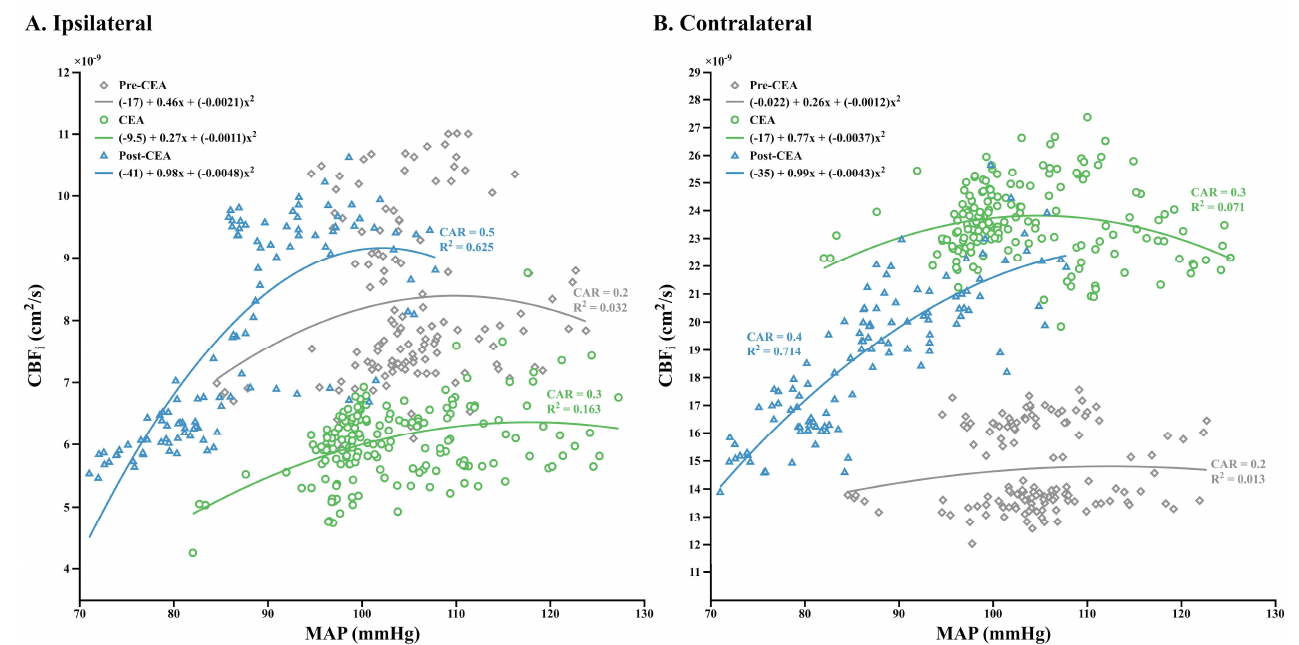
Figure 5. A representative case of ipsilateral ( A ) and contralateral ( B ) CBF i versus MAP in a patient (#21, MCS group). In the ipsilateral hemisphere, there was a decrease of CBF i for MAP below 85 mmHg during the post-CEA phase, suggesting the loss of cerebral autoregulation for these MAP values. In contrast, during the pre-CEA and CEA phases, CBF i did not increase despite MAP being above 120 mmHg, as this patient was still in the autoregulatory range. The pre-CEA, CEA, and post-CEA phases are represented as grey diamond, green dotted, and blue triangle symbols, respectively. CAR values are the computed cross-correlation coefficients with respect to our method. The least-squares method is used to find a polynomial fit of the maximum degree of two and R 2 values are the results of curve fitting. The fit results are shown in color with respect to phases. CBF i , cerebral blood flow index; MAP, mean arterial pressure; CEA, carotid endarterectomy; CAR, cerebral autoregulation.